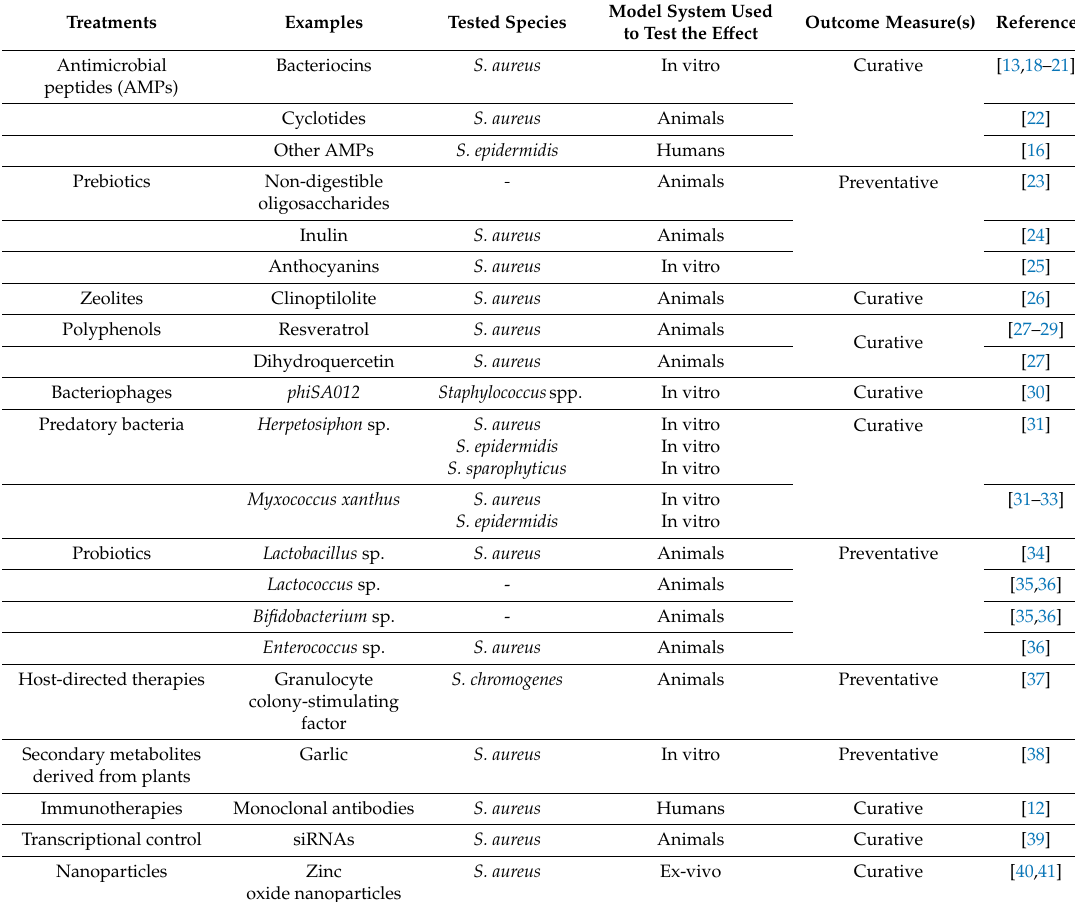
(Table 2). Moreover, bacteriocins can inhibit S. aureus ’ biofilm formation, especially relevant to host colonization [18,19]. Table 2. List of the most promising alternative anti-infective treatments to traditional anti-biotherapy against